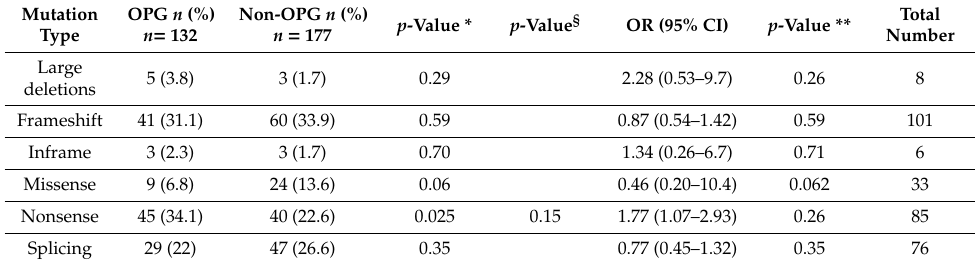
Table 4. Distribution of NF1 mutation types in the OPG and non-OPG